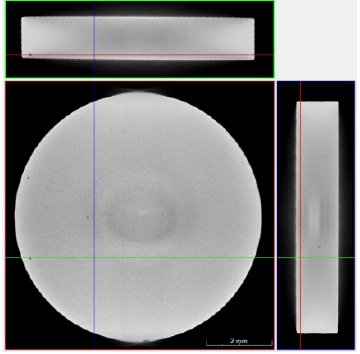
Figure 4. Three-dimensional image of Er (0.5 mol.%):Y 2 O 3 ceramics.